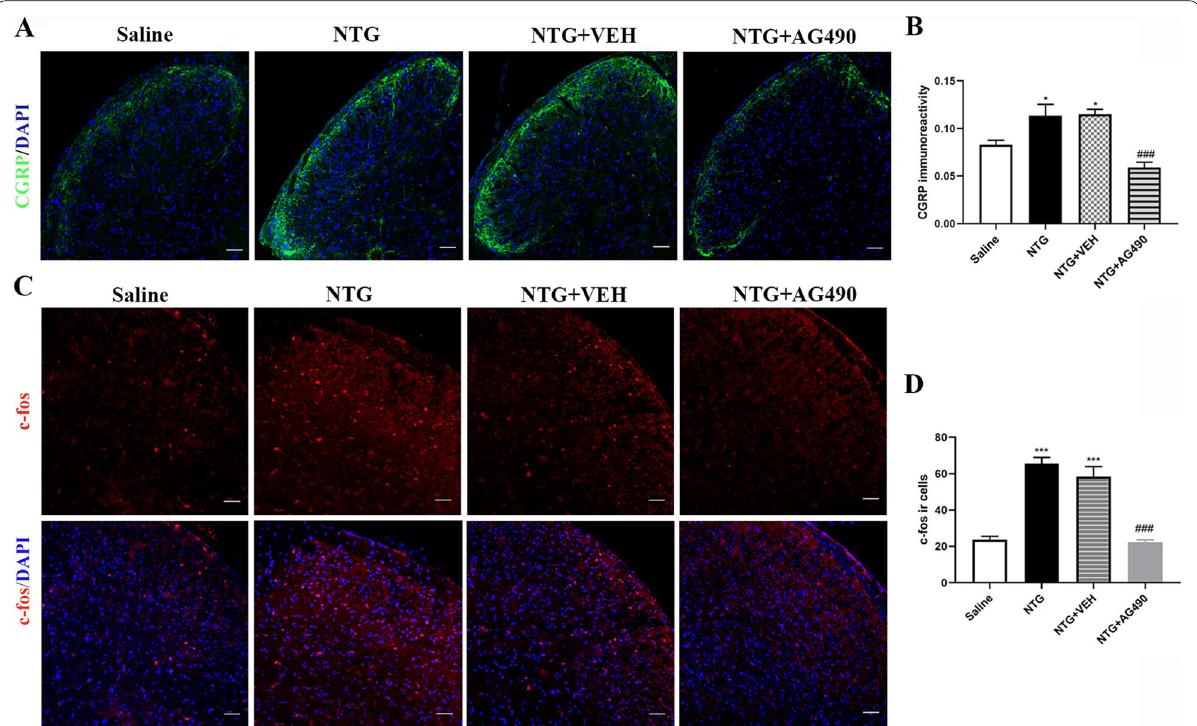
Fig. 7 Inhibition of STAT3 activity could suppress the expression level of CGRP and c-fos. A, B Representative immunofluorescence staining images (A) and quantitative analysis of CGRP in the TCC area among the Saline, NTG, NTG of AG490 inhibited the increased immunoreactivity of CGRP induced by chronic NTG administration. n ### p < 0.001 vs. NTG group. Scale bars 50 μm. C , D Quantitative analysis of c-fos immunoreactive (ir) cells indicated daily administration of AG490 = decreased c-fos ir cells. n 4/group; *** p < 0.001 compared with the Saline group; ### p < 0.001 for the NTG = group. Scale